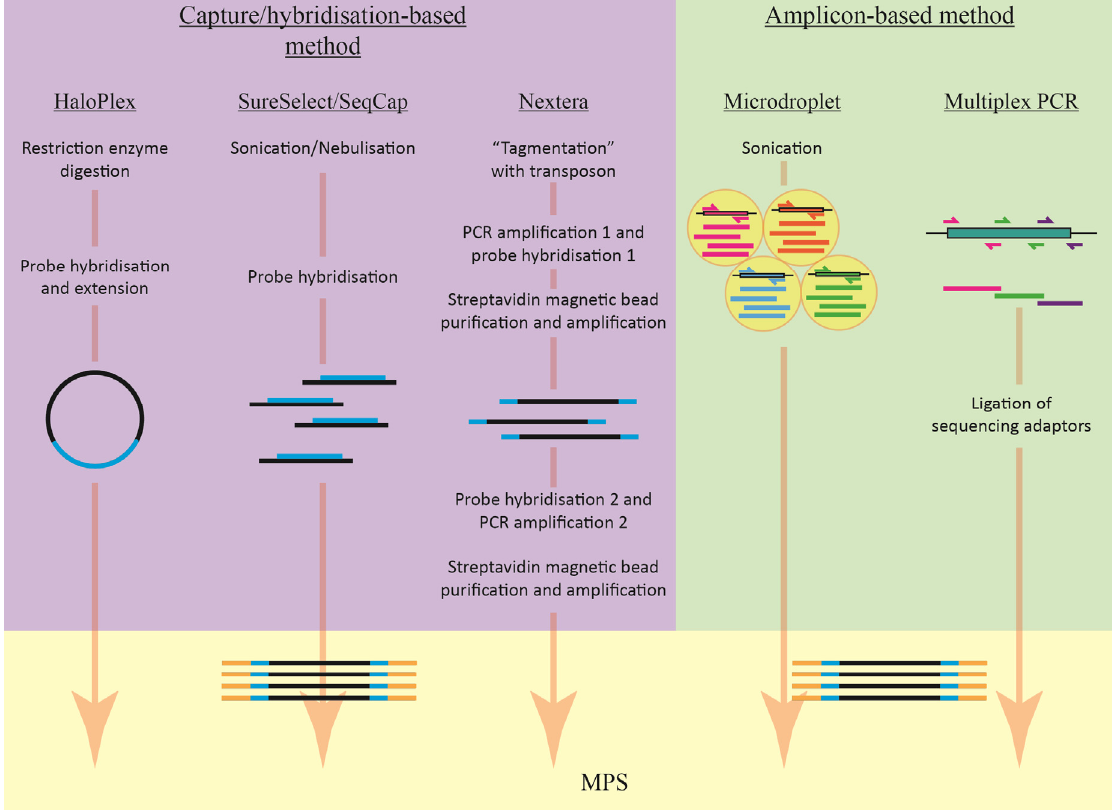
Figure 3. The basic workflow of amplicon-based and capture/hybridisation-based methods. The blue lines in the capture/hybridisation-based method section represent target-specific probes; the orange/yellow lines represent the adaptors. The differently-coloured lines in the amplicon-based method section represent the different amplicons being